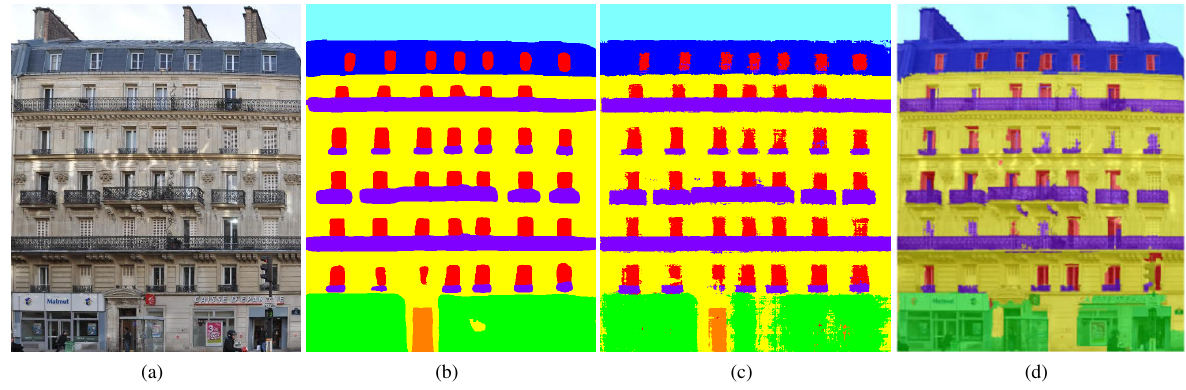
Figure 1. Qualitative results of different methods. (a) shows the input image, (b) the output of our method and (c) the result of (Jampani et al., 2015) which is learned with boosted decision trees after three iterations of Auto-context (Tu, 2008). (d) depicts the output of (Martinovi´c, 2015) which employs superpixel classification. The class labels are described in Fig. 2 Database (ECP) facade dataset (c.f. Section 5.1). In comparison, our approach takes less than 10 seconds per image.